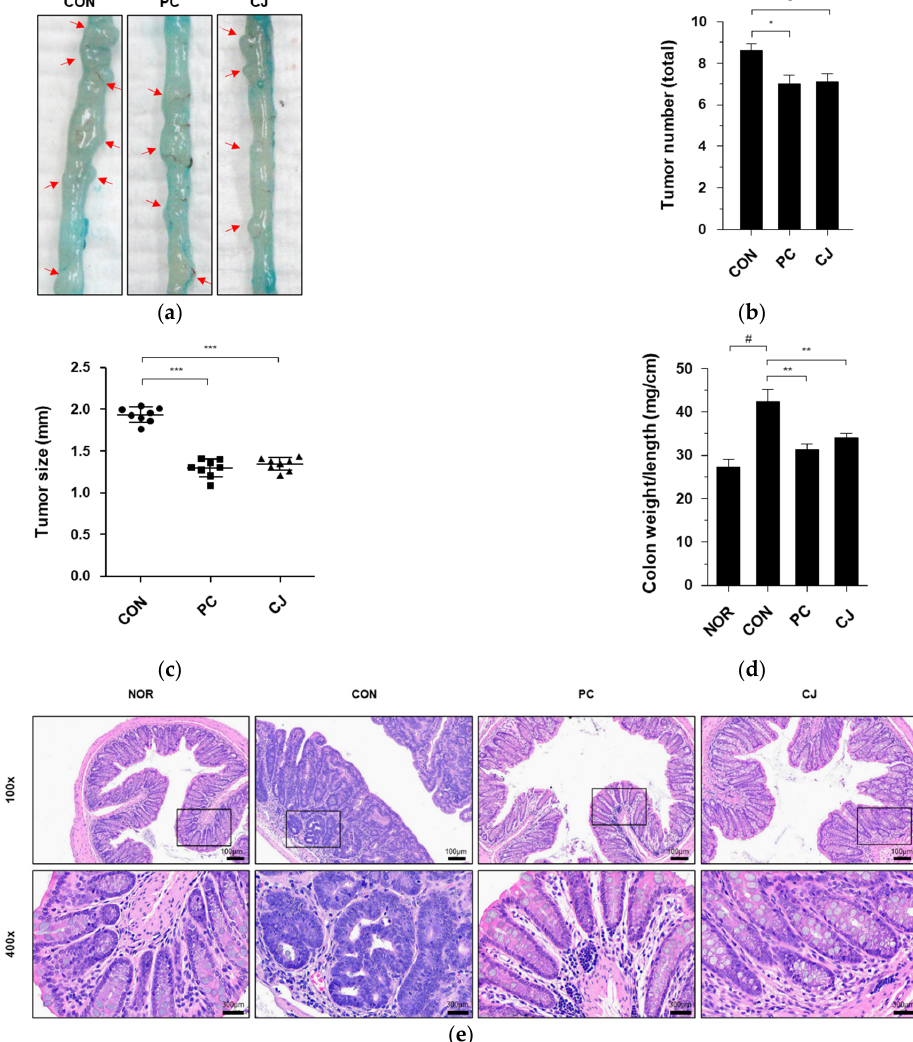
Figure 2. Effects of CJ on tumorigenesis in mice with AOM/DSS-induced CAC. ( a ) Representative pictures of colon tissue in the different groups of mice. Arrow indicates a tumor. Shown are the ( b ) total number of tumors, ( c ) tumor size, and ( d ) ratio of colon weight-to-colon length in the different groups of mice. All values are mean ± standard deviation ( n = 8). ( e ) Representative histology for H&E staining of colon tissue. Magnification, 100× and 400×; Scale bar; 100 μ m and 300 μ m; NOR, normal group; CON, control group; PC, positive control group; CJ, cheonggukjang treated group. #, p < 0.05 versus normal group; ***, p < 0.001; **, p < 0.005; *, p < 0.05 versus control